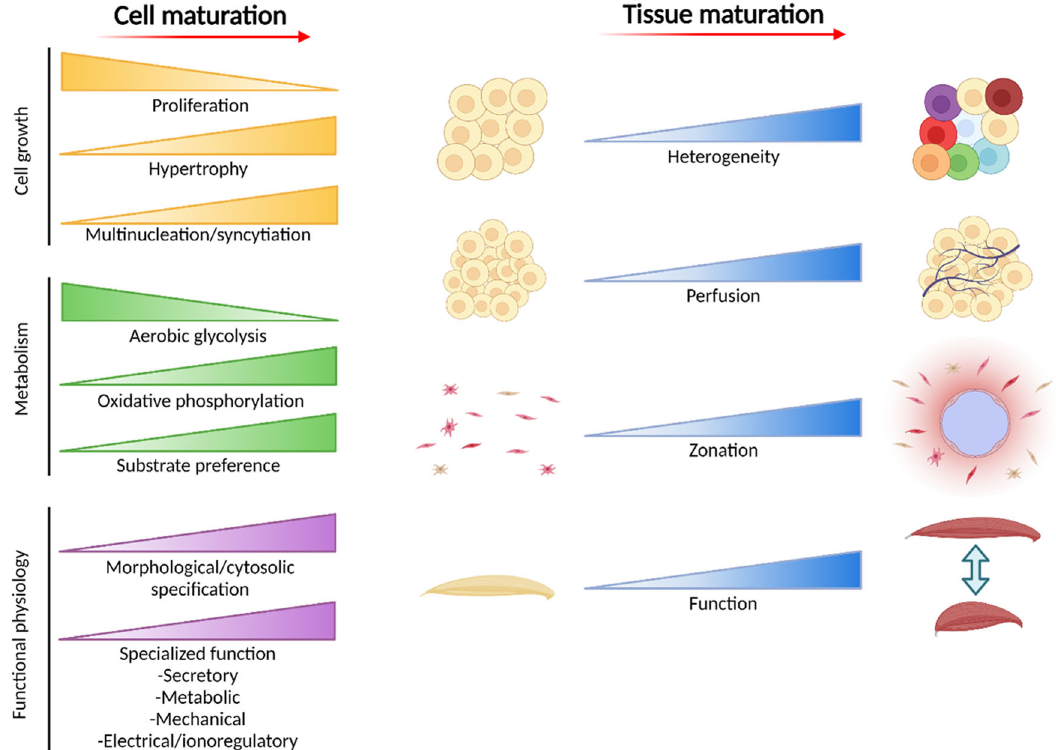
Fig. 1 Common physiological trends in cell and tissue maturation. As metabolically provided energy is diverted from proliferative activity to physiological function, cell complexity, and functional parameters are improved. This increasing specialization necessitates an investment of energy to manage cell size, structure, and specialized structures or organelles. The energetic outlay and continued fl ux for this expenditure is generally maintained by high-yield and ef fi cient oxidative phosphorylation from lipids, short-chain fatty acids, carbohydrates, amino acids, lactate, and/or ketones, depending on the speci fi c tissue and stage of maturation in question. Metabolic supply is provided by increased perfusion and spatial zonation, at which point the tissue can then exert its hallmark function. Image created using